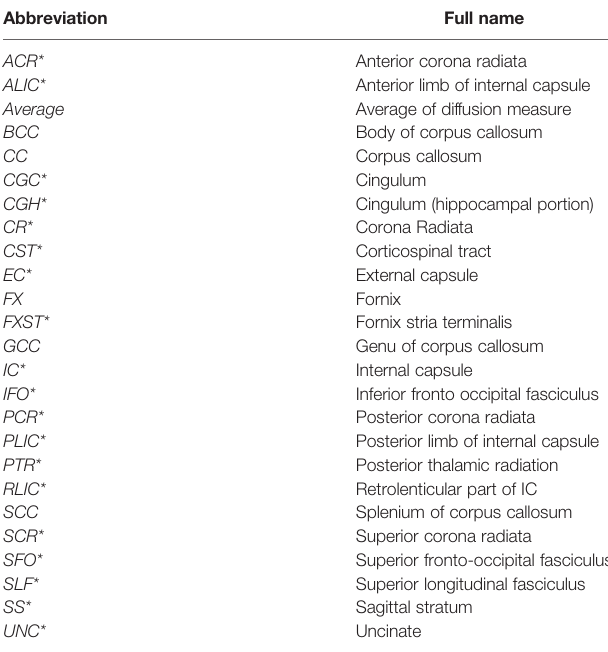
TABLE 1 | Overview of the investigated white matter regions of